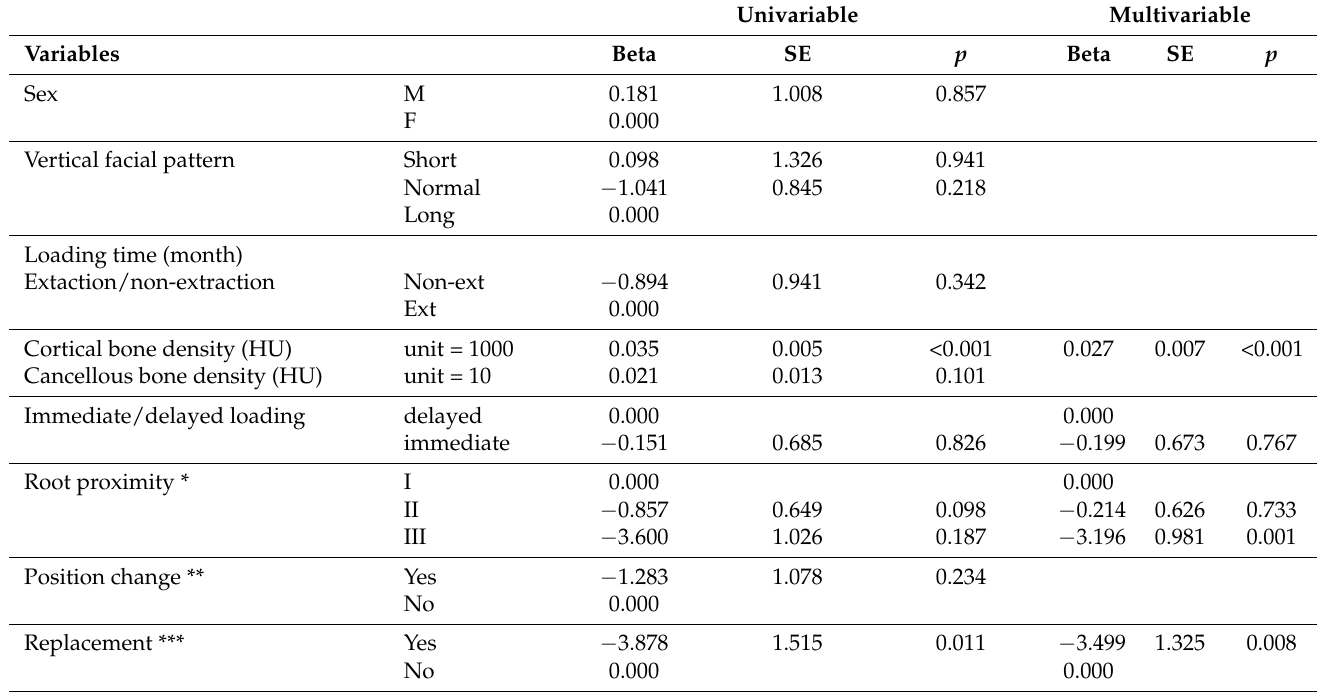
Table 5. Regression analysis for loading